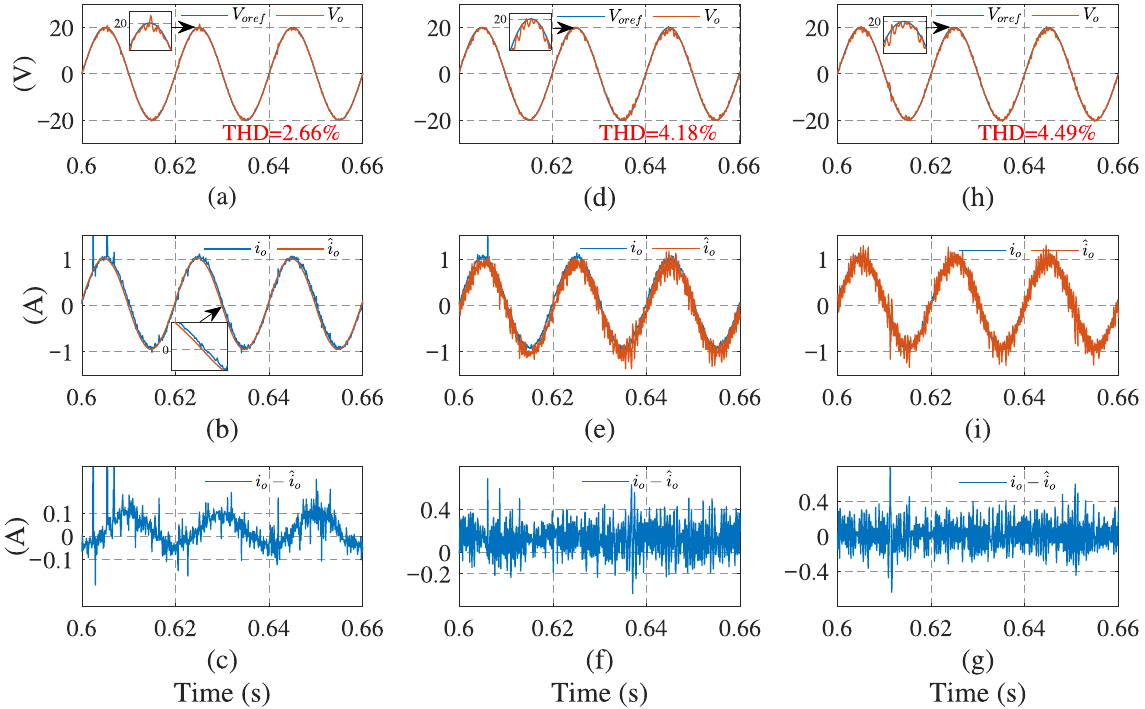
Figure 10. System experimental results using current estimation method under linear load: ( a , d , h ) out- put voltage of observer, Kalman filter, and low-pass filter, respectively; ( b , e , i ) load currents of the three methods, respectively; ( c , f , g ) current estimation errors of the three methods,